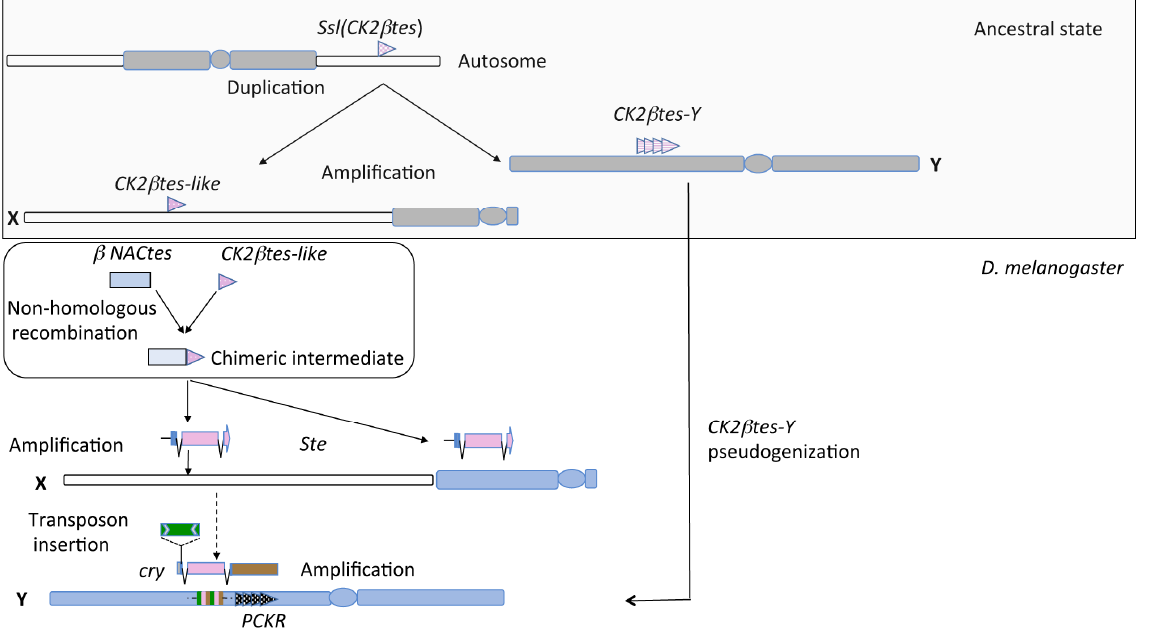
Figure 2. Diagram showing the inferred evolutionary history of the cry-Ste system. In the melanogaster complex ancestor, the Ssl gene translocated on the sex chromosomes. The copy translocated on the Y chromosome, amplified generating the CK2 β tes-Y repeats. In D. melanogaster , on the Y chromosome a pseudogenization of CK2 β tes-Y generated PCKR. A non-homologous recombination of CK2 β tes-like gene and an X-linked gene family called NAC β tes , generated a chimeric intermediate; a duplication event then generated the Ste genes that evolved independently to the Ste eu and Ste het loci on the X chromosome. The insertion of a Hoppel transposon and the following amplification on the Y chromosome finally produced cry genes.